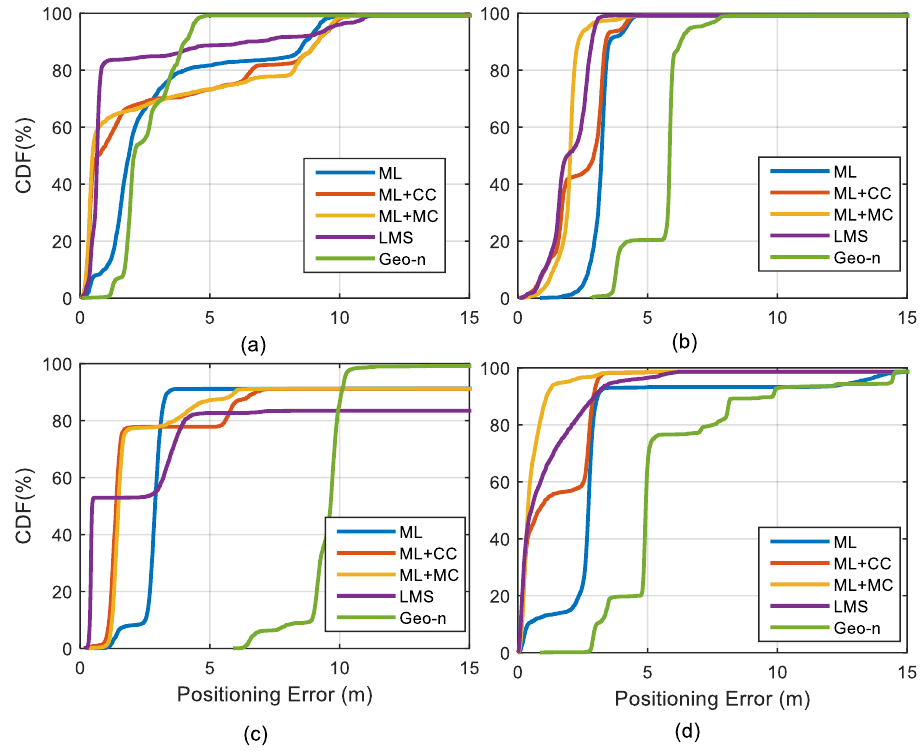
Figure 17. CDF comparison of different robust location estimators. ( a ) MS 1; ( b ) MS 2; ( c ) MS 3; ( d ) MS 4.